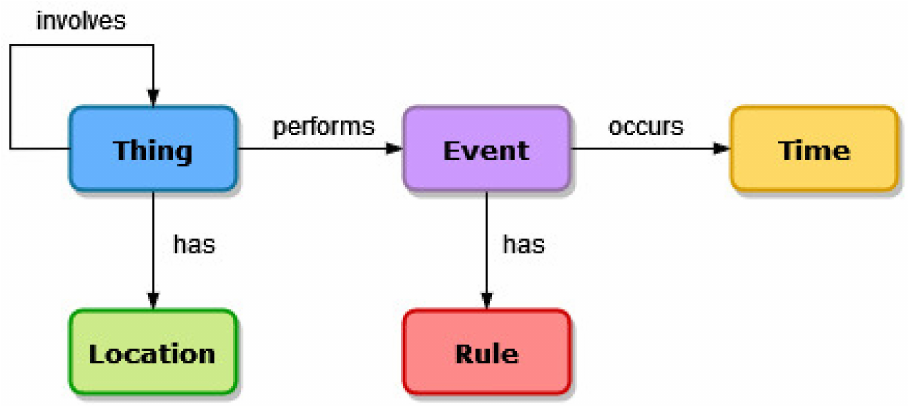
Figure 6. Modeling structure the five core ontologies and their relations.